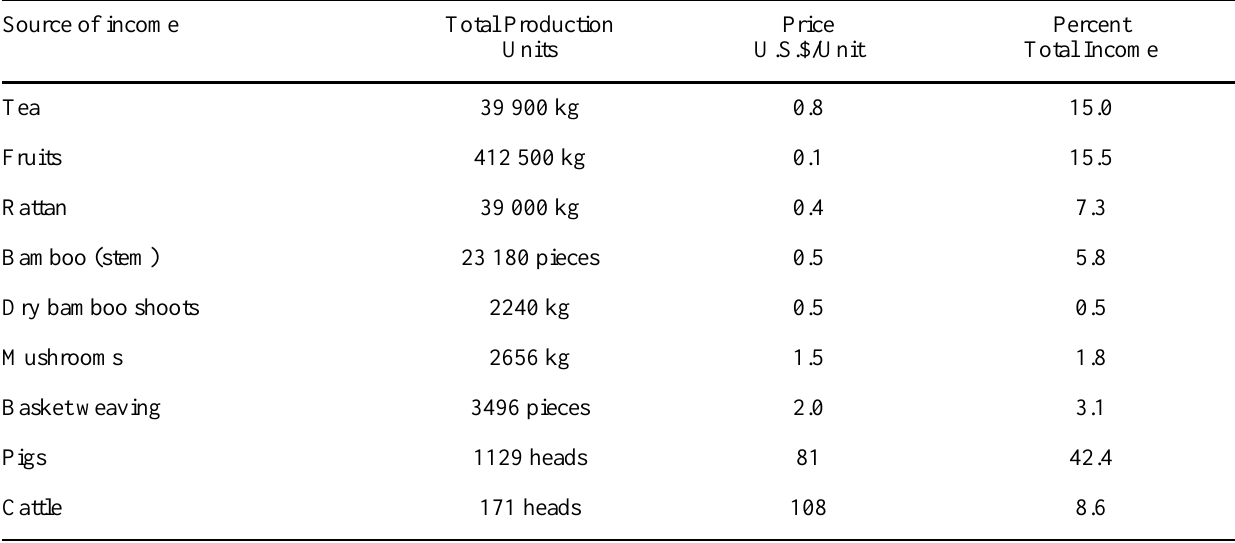
Table 3. The main sources of cash income in Mengsong in 1989 (Xu 2006b). U.S.$1 = CNY 3.7 at 1989 exchange